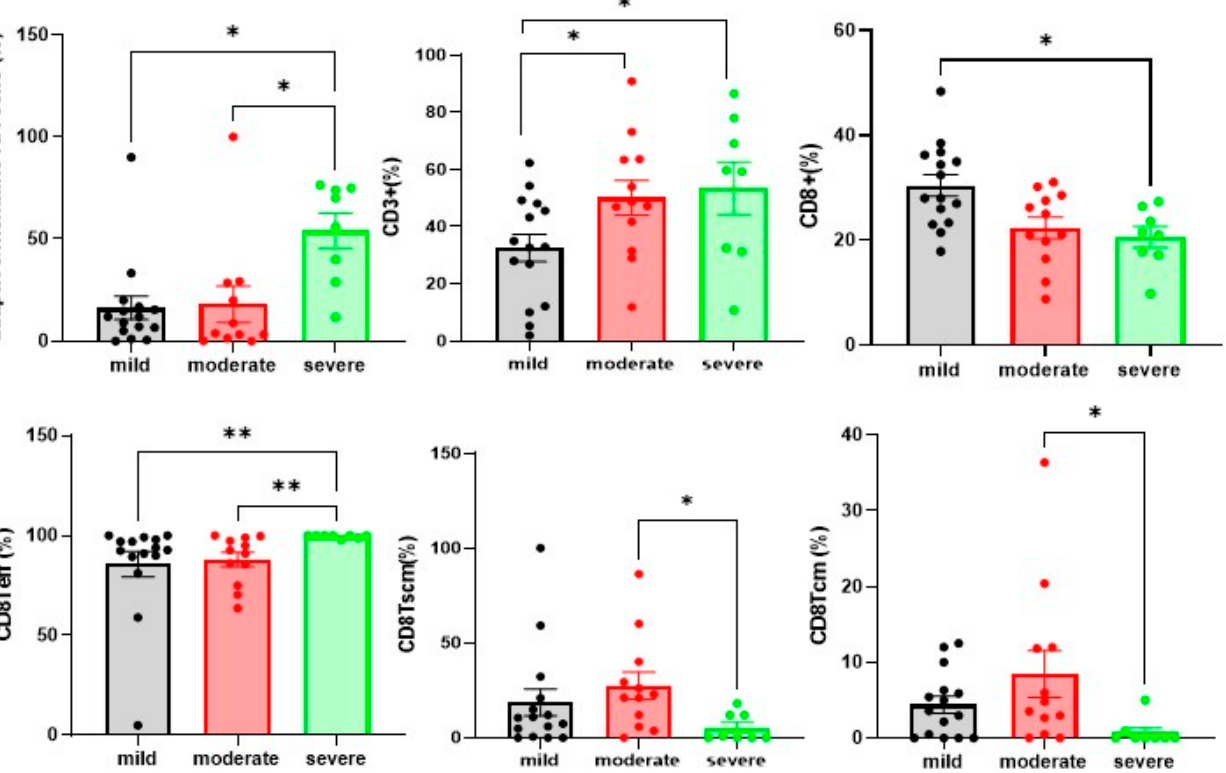
Figure 4. COVID-19 patients showed an imbalanced proportion of T cell subsets in peripheral blood T cells. Percentages of adaptive/mem.like NK cells. CD3 + T cells. CD8 + T cell subsets of total PBMCs from mild cases (n = 15). moderate cases (n = 12). and severe cases (n = 8). The level of significance is indicated as follows: * p < 0.05. ** p < 0.01.